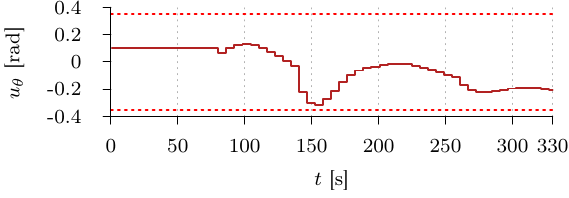
Figure 9: The optimized control input that are used together with the low-fidelity vehicle model to construct the desired paths for the mobile sensor. The input remains within the upper and lower constraint, which are indicated by dashed